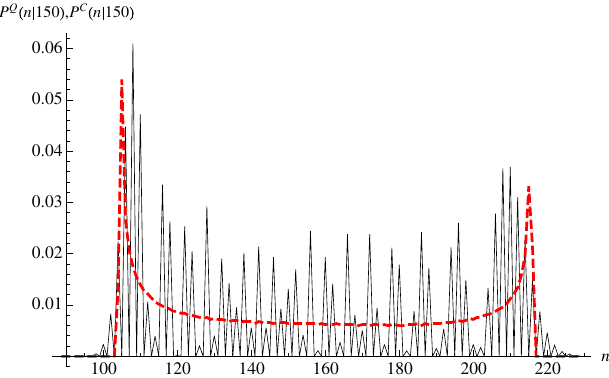
FIG. 2. Quantum [Eq. (22)] and classical [Eq. (16)] transition probabilities for the forced quartic oscillator. The solid black curve shows P Q ð n j m Þ , while the dashed red curve shows P C ð n j m Þ , for m ¼ 150 .